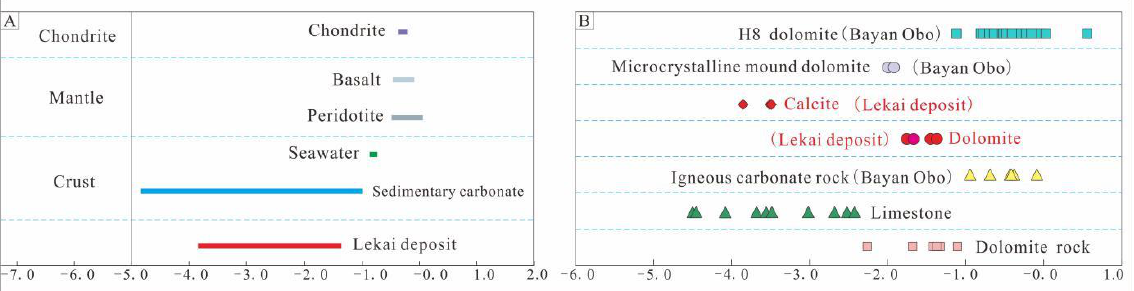
Figure 10. ( A ) Magnesium isotopic composition of different reservoirs of the Earth (Chondrite [13]; Mantle [34]; Crust [23,33]; ( B ) Magnesium isotopic composition of Lekai Pb-Zn deposit and Bayan Obo deposit (Bayan Obo deposit [63]).